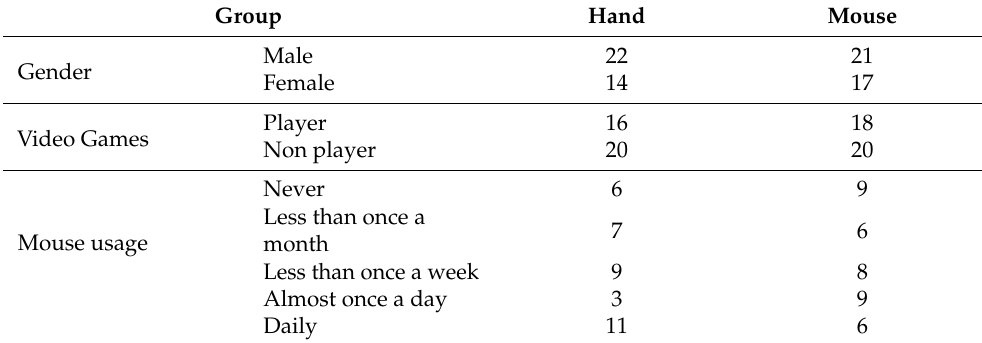
Table 1. Characteristics of